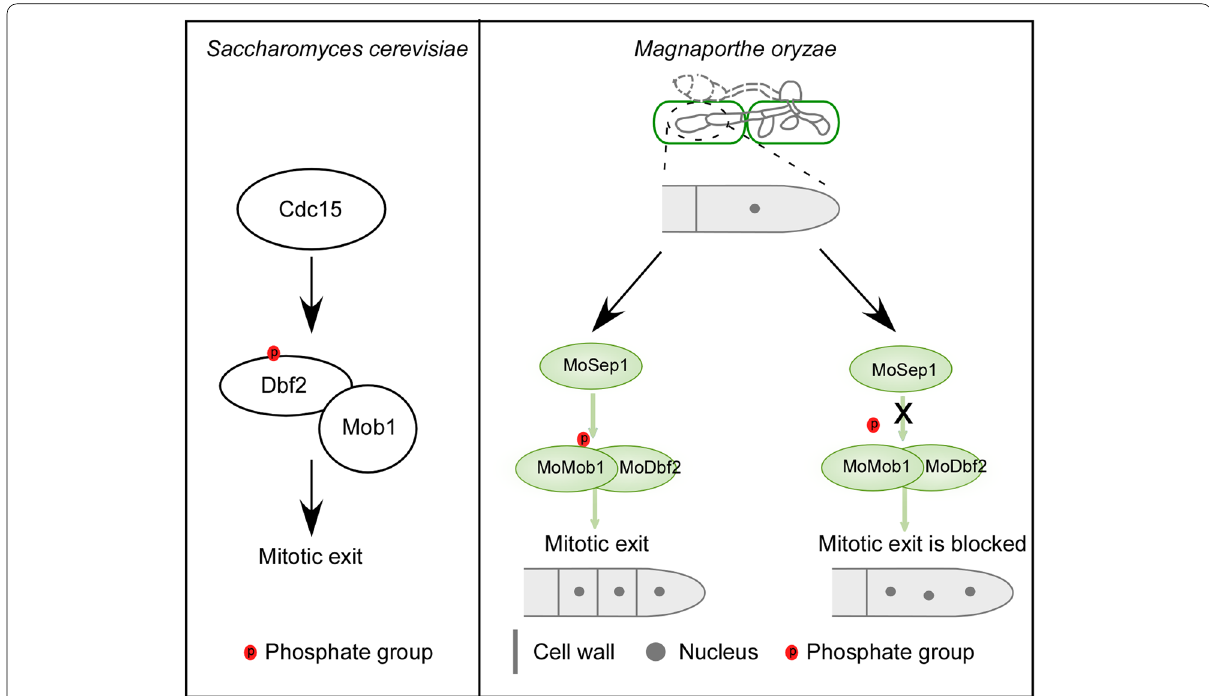
Fig. 7 Comparison of mitotic exit network (MEN) signalling between Magnaporthe oryzae MoSep1-MoMob1-MoDbf2 and Saccharomyces cerevisiae Cdc15-Dbf2-Mob1. In the rice blast fungus Magnaporthe oryzae , the MEN pathway, consisting of conserved protein kinases MoSep1 and MoMob1-MoDbf2, is important in the development and pathogenicity of the fungus. M. oryzae Cdc15 homolog MoSep1 showed core functions in the MEN pathway important for growth, development, and pathogenesis. However, MoSep1 directly regulates MoMob1 phosphorylation, but not MoDbf1, in contrast to S. cerevisiae . In M. oryzae , when the phosphorylation of MoMob1 by MoSep1 is blocked, septa could not be normally